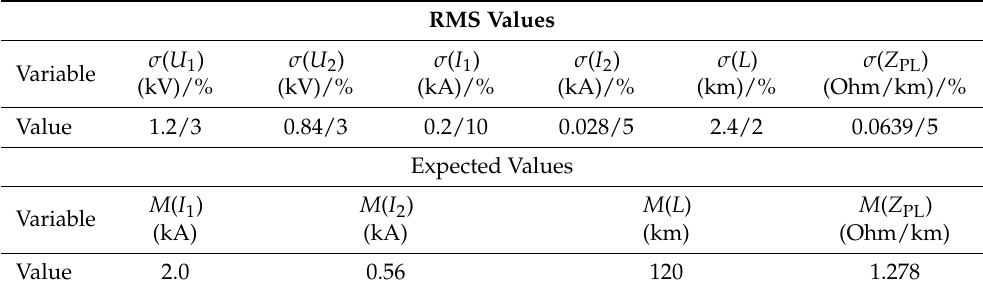
Table 1. Variables for analytical calculation of OPL FL